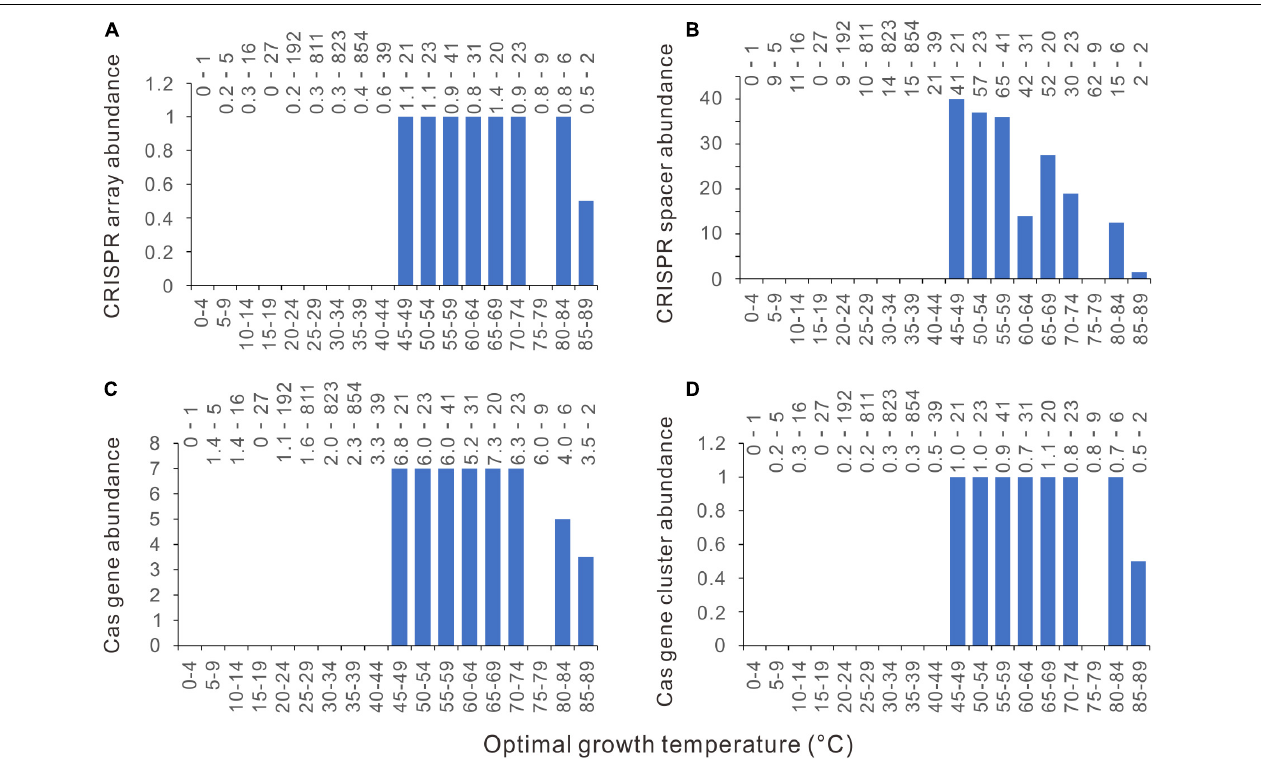
FIGURE 6 | Relationships between Type I CRISPR-Cas abundances and optimal growth temperatures (Topt). (A) CRISPR arrays. (B) CRISPR spacers. (C) cas genes. (D) cas gene clusters. Because median values are less sensitive to extreme outliers than the mean values, we created the column charts using the median value of each Topt range. The mean value and the number of genomes of each bin (separated by a hyphen) are shown at the top of each